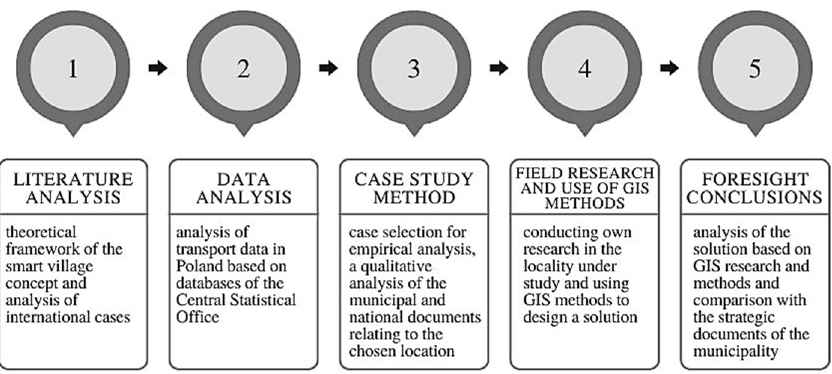
Figure 1. Research methodology in the subsequent phases.